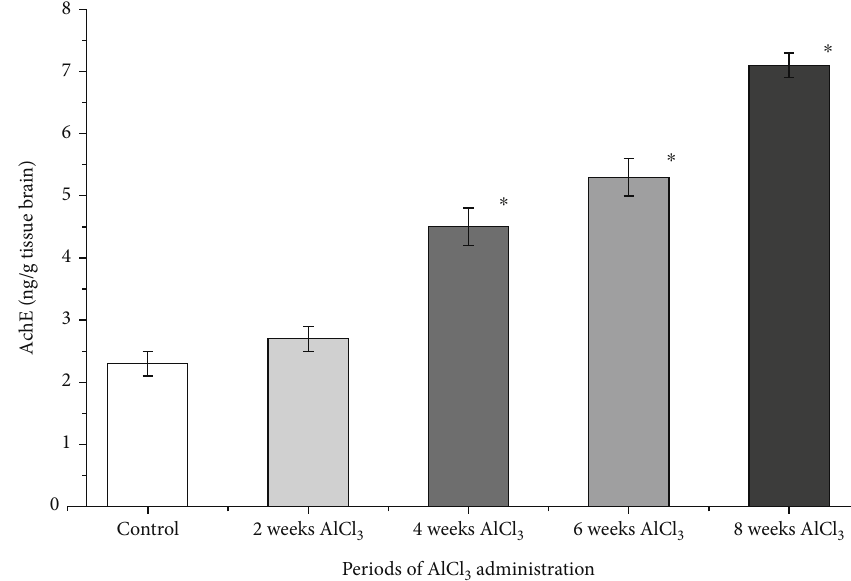
Figure 2: Histogram for the brain content of AchE in rats given 100 mg/kg b.w. of AlCl